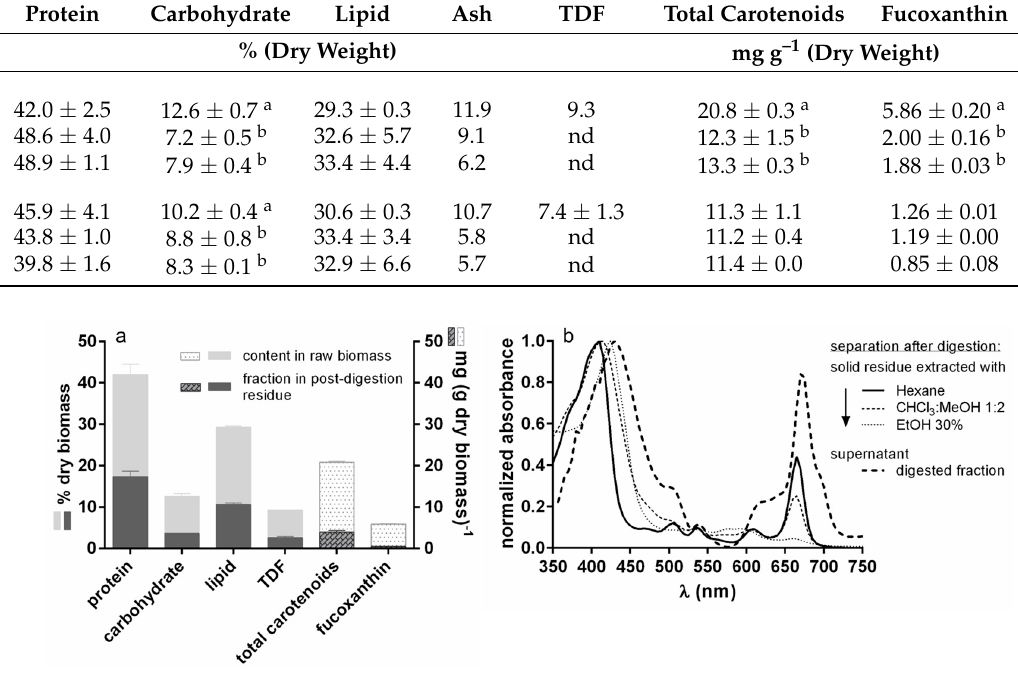
Figure 6. Distribution of raw biomass components in the different digestion fractions. ( a ) Fraction of the components of T. lutea F&M-M36 raw biomass remaining in the solid residue after the digestion process. Data are expressed as mean ± standard error. ( b ) Normalized absorbance spectra of the pigments in extracts from the solid post-digestion T. lutea F&M-M36 residue and in the supernatant containing the digested fraction.